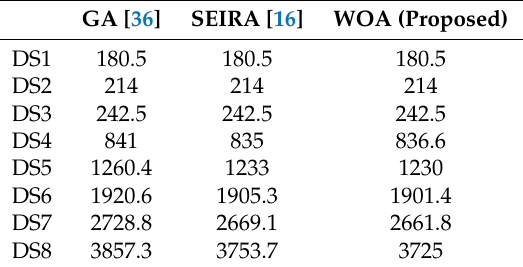
Table 9. Result and comparison.